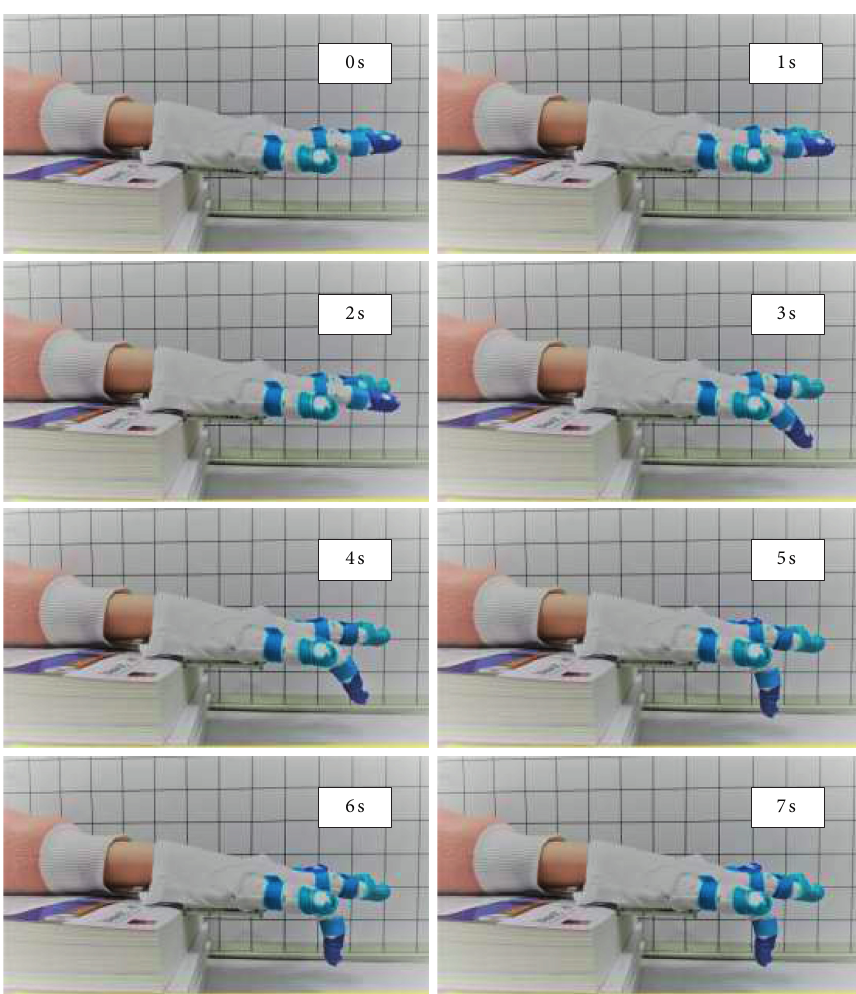
Figure 9: Index finger postures after actuation for 1s time